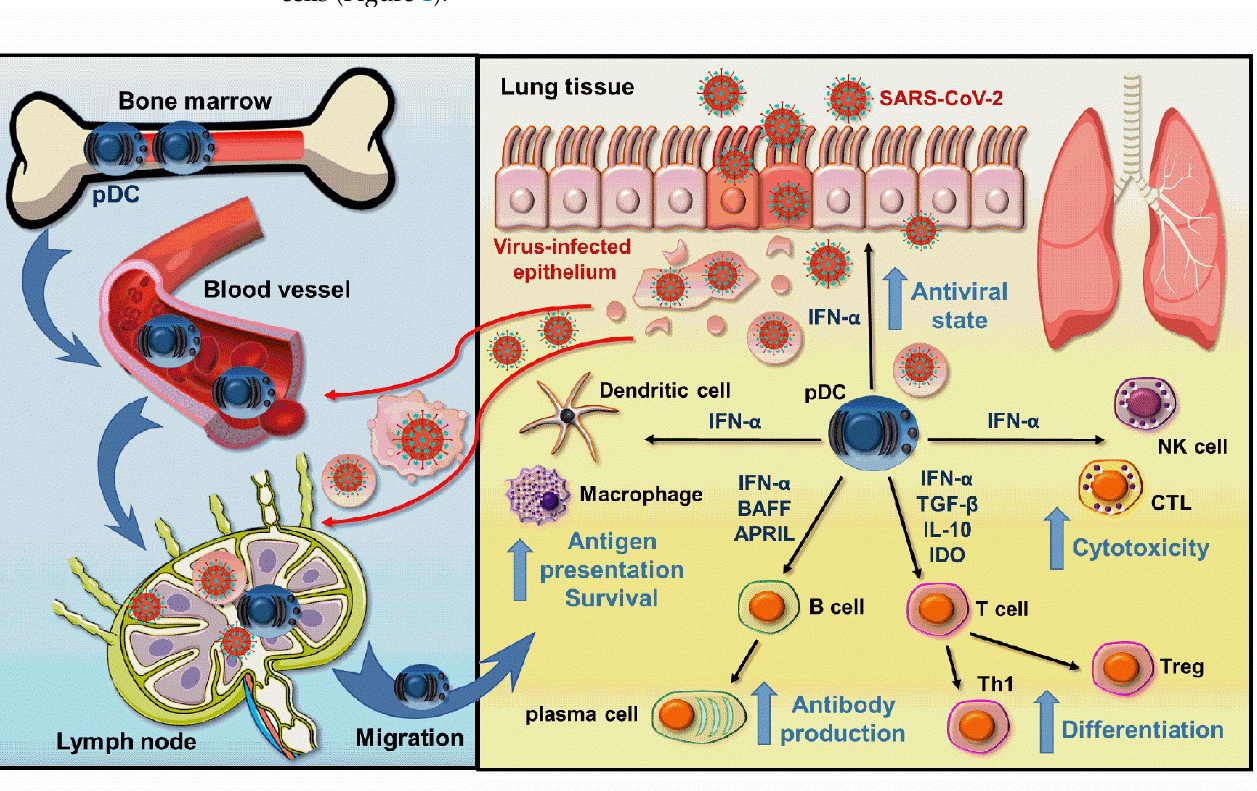
Figure 1. Beneficial effects of pDC-derived type I IFNs help to overcome SARS-CoV-2 infection. When the SARS-CoV-2 viruses break through the first line of defense ensured by the epithelial cells, viral particles or cell debris derived from virus-infected cells are delivered to the draining lymph nodes, where pDCs are stimulated to migrate to the entry site of the viruses. Here, the pDC-derived type I IFNs initiate an antiviral state in the host cells, which effectively blocks viral replication, and also promotes the activation and function of both innate and adaptive immune cells thereby creating an effective antiviral response. APRIL: A proliferation-inducing ligand; BAFF: B-cell activating factor; IL: interleukin; IDO: Indoleamine 2, 3-dioxygenase; IFN: interferon; NK: natural killer; pDC: plasmacytoid dendritic cell; TGF: Transforming Growth Factor; Th: T helper; Treg: T regulatory; CTL: cytotoxic T cell.